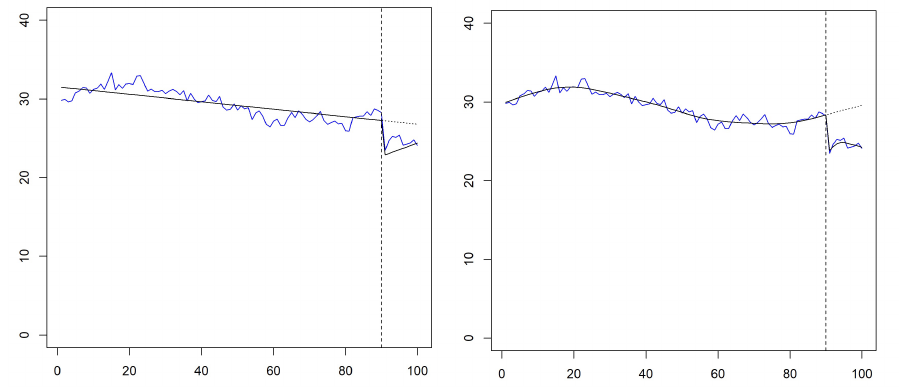
Figure 2. Results for simulated data. The left plot shows the segmented linear regression analysis and the right plot shows the generalized additive analysis. In both pictures, the blue line refers to the simulated data, the black line refers to the fitted values and the dashed line refers to the projection of the pre-intervention model in the post-intervention period.